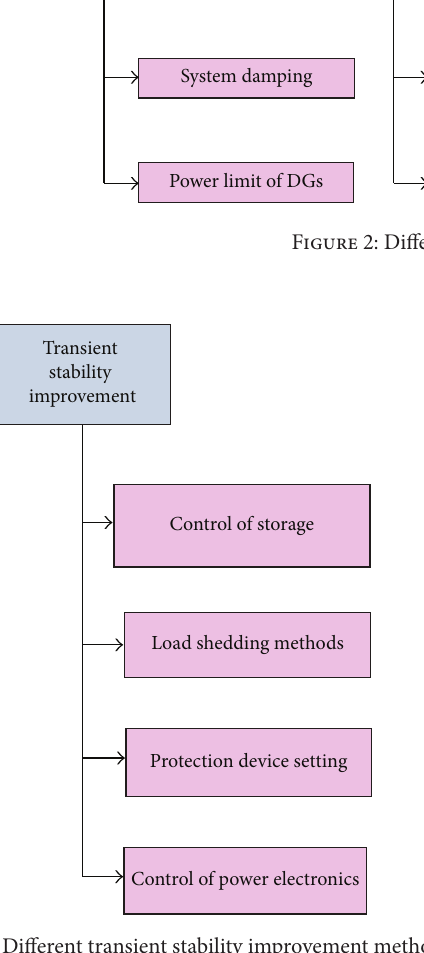
Figure 3: Different transient stability improvement methods.